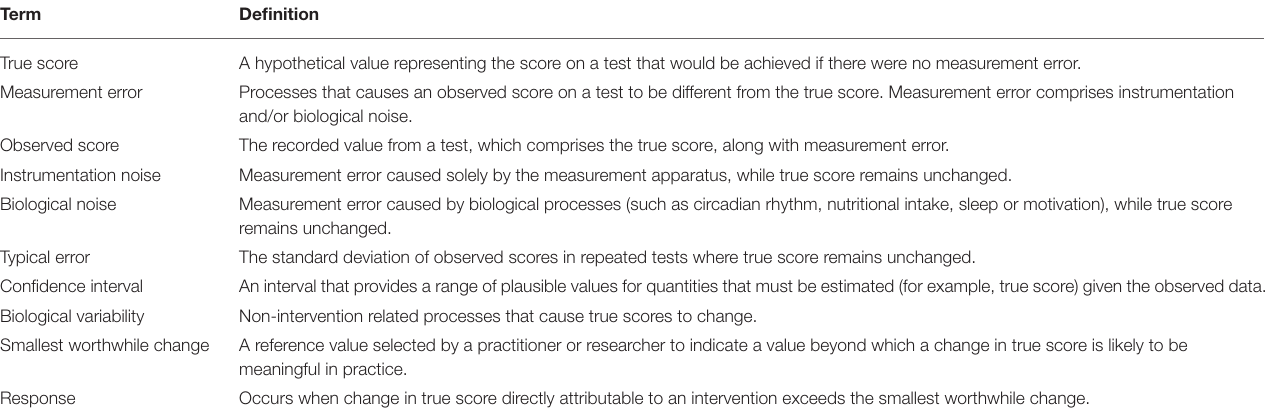
TABLE 1 | Definitions of key